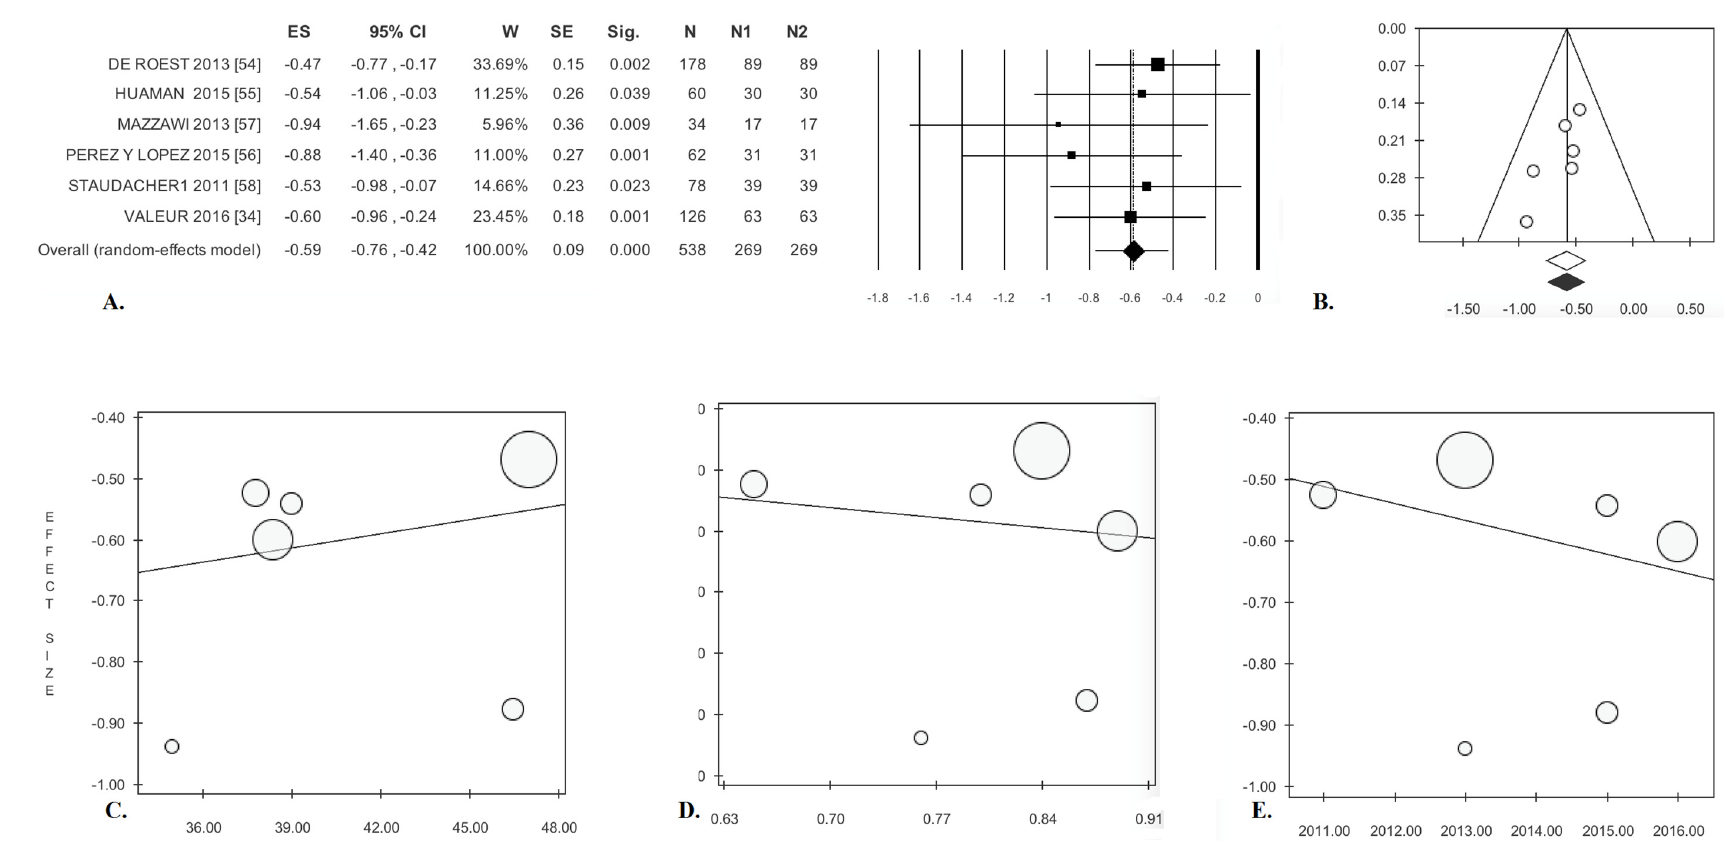
Figure 5. Low-FODMAP diet in cohort studies. Abdominal pain: ( A ) forest plot and ( B ) funnel plot. Meta-regression: ( C ) mean age, ( D ) gender, and ( E ) publication year.